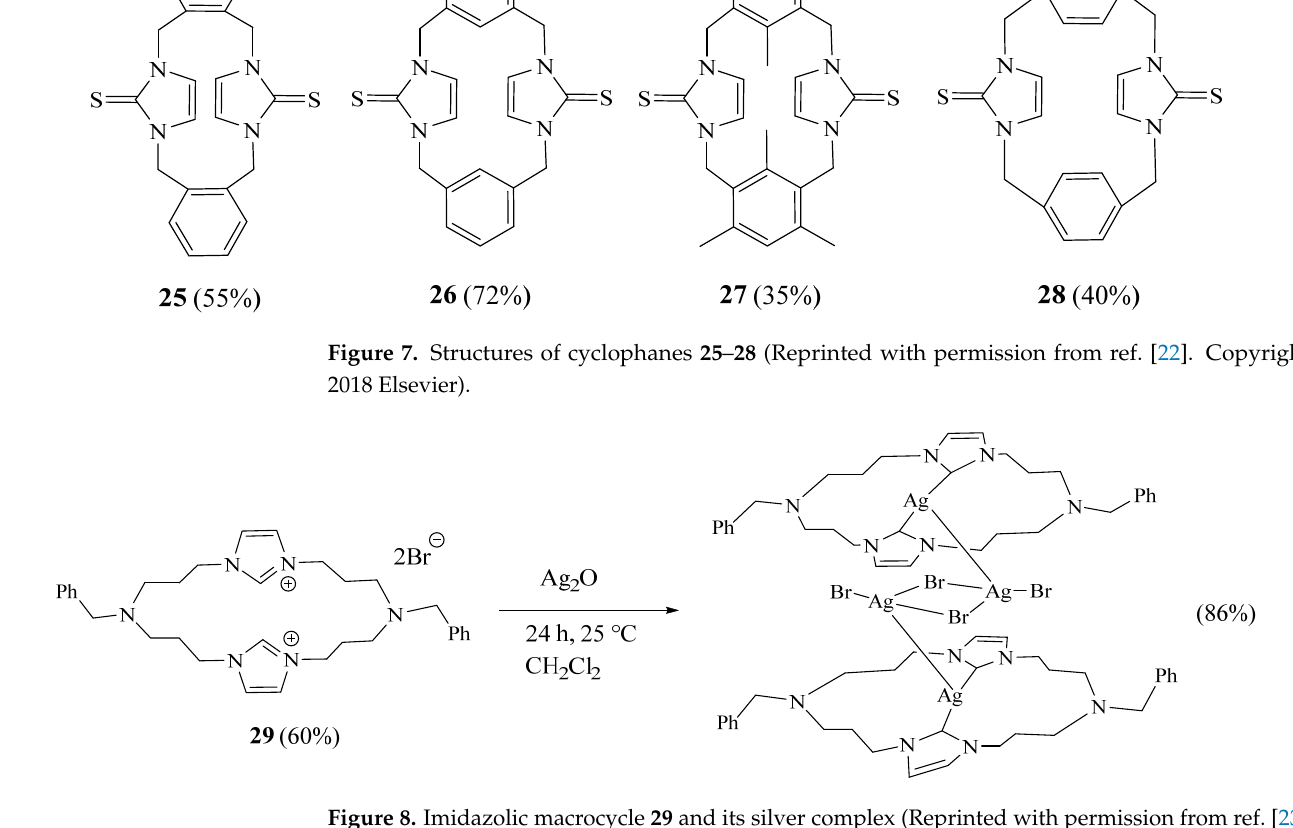
Figure 8. Imidazolic macrocycle 29 and its silver complex. (Reprinted with permission from ref. [23]. Copyright 2019 Royal Society of Chemistry).